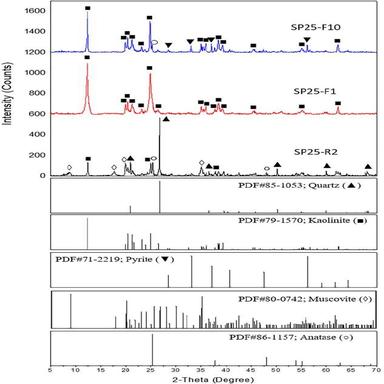
XRD patterns of the three segments (SP25-F10, SP25-F1, and SP25-R2) of the Guxu core sample (▲ – Quartz; ■ – Kaolinite; ▾ – Pyrite; ◊ – Muscovite; ○ – Anatase).